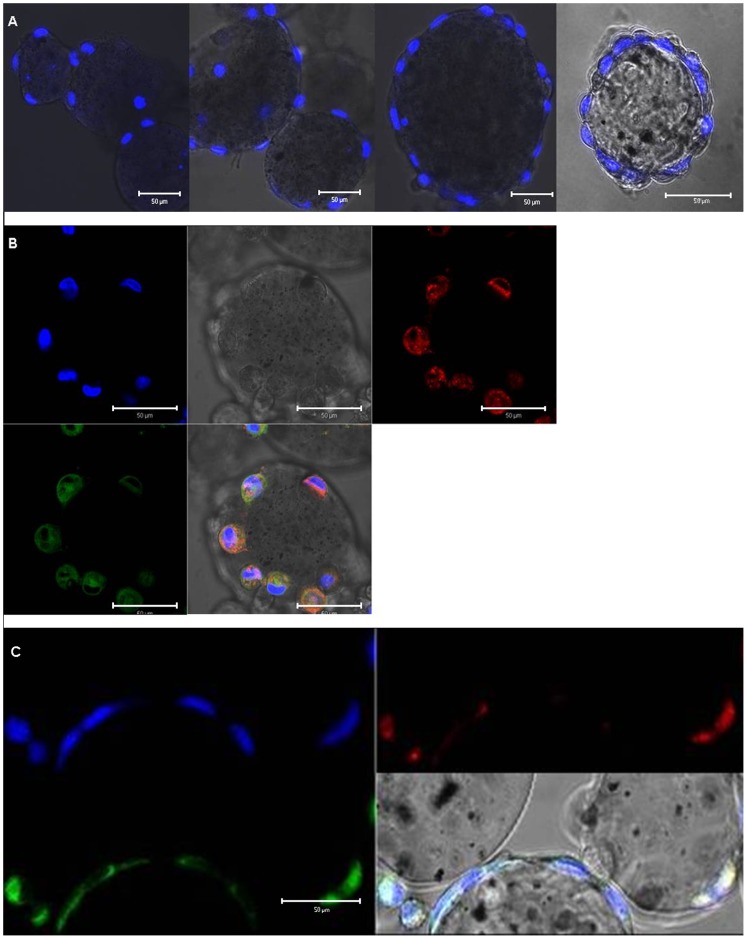
EAhy 926 attached to GEM™.Nuclear staining with 5 µg/ml Hoechst 33342 was performed 1, 5, 7, and 14 days after inoculation (A). Vital dye staining for ER and mitochondria five days after inoculation. Hoechst 33342 dye was used as nuclear counterstain (B). Internalized red fluorescent NPs co-localize with the lysosomal dye LysoSensor™ Green DND-189 but not with the nucleus (blue) (C).